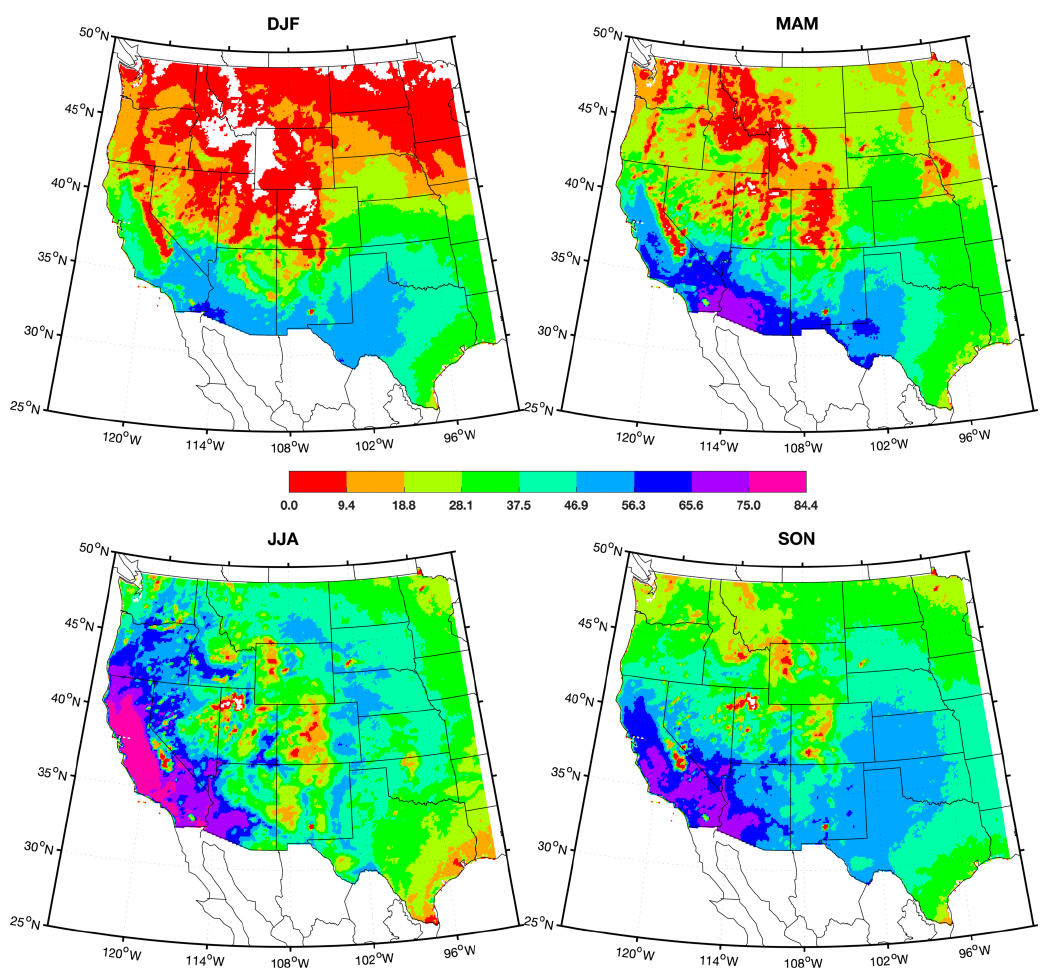
Figure 2. Seasonal distribution of the number of MODIS DB AOD retrieval per 0.1 ◦ × 0.1 ◦ averaged from January 2003 to December